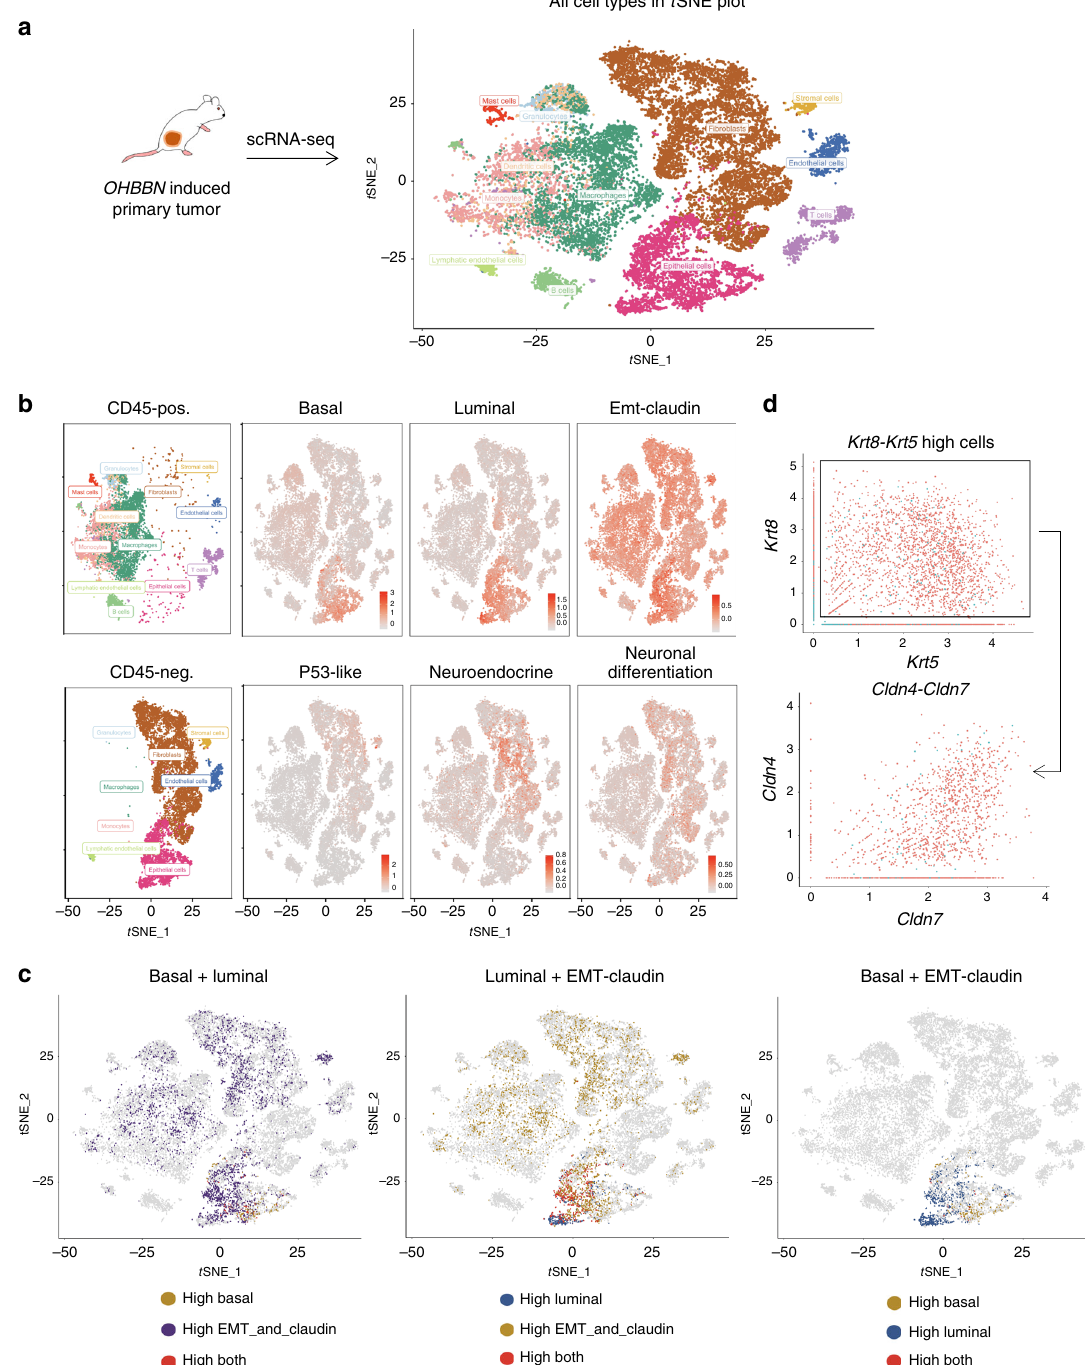
Fig. 1 Single-cell transcriptome pro fi ling of OHBBN-induced mouse bladder tumors. a tSNE plots showing a total of 22 clusters identi fi ed from CD45- negative and CD45-positive fractions isolated by fl ow cytometry from OHBBN-induced primary bladder tumors (pooled tumors, n = 3 tumors). b tSNE plots showing the proximity of cells with high expression of genes belonging to basal, luminal, and EMT-claudin lineage subtypes within Epcam-positive de fi ned populations. c Single-cell gene plots gated on cells with high Krt5 and Krt8 gene expression followed by the assessment of EMT-claudin genes ( Cldn4 , Cldn7 ). Cells with Krt5 > 0 and Krt8 > 0 expression were gated as Krt5 - Krt8 high, whereas cells with Krt5 = 0 and Krt8 = 0 were gated as Krt5 - Krt8 low. Axis units are log (UMI) or transformed transcripts per cell. d tSNE plots showing the presence of bi-lineage-positive cells using gene expression overlays from (left) basal + luminal, (middle) luminal + EMT-claudin, and (right) basal + EMT-claudin subpopulations. Tumor identi fi cation and cell numbers sequenced were as follows: tumor 4950 (CD45-neg = 2939 cells, CD45-pos = 1307 cells), tumor 8524 (CD45-neg = 6119 cells, CD45-pos = 2736 cells), and tumor 8525 (CD45-neg = 5068 cells, CD45-pos = 7564 cells). Genes assessed in tSNE plots are shown in Table 1. Top up and down genes are shown in Supplementary Data